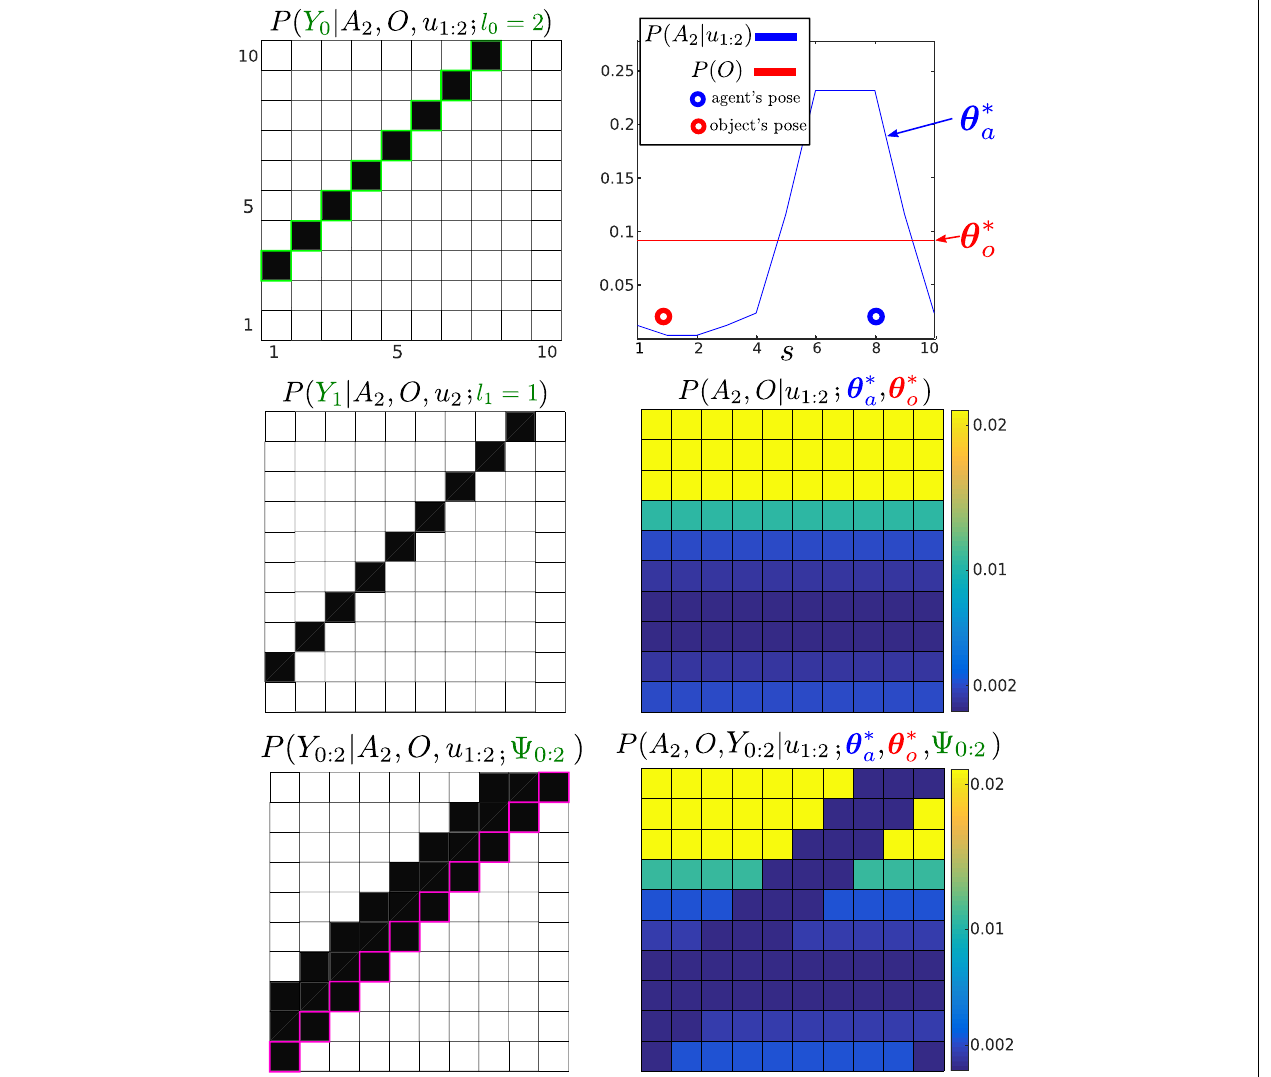
FIGURE 6 | Un-normalized MLMF joint distribution, numerator of equation (12), at time t = 3. Three measurements (all Y = 0) and two actions (both u = 1) have been integrated into the joint distribution, for simplicity we do not consider any motion noise. Left column: the first plot illustrates the likelihood of the first measurement Y 0 . We highlight the contour in light-green to indicate that it was the first applied likelihood function (see the correspondence with Figure 5 ). The first likelihood function has been moved by the 2 actions, the second likelihood function has been moved by one action (the last one, u 2 = 1), and the third likelihood has had no action applied to it yet. The last applied likelihood function is highlighted in pink, and the product of all the likelihoods since t = 0 until t = 3 is depicted at the bottom of the figure, which is P ( Y 0:2 | A 2 , O , u 1:2 ). Right column: the top figure illustrates the original marginal of the object P ( O ; (cid:18) (cid:3) o ) , which remains unchanged, and the agent’s marginal P ( A 2 | u 1:2 ; (cid:18) (cid:3) a ) , which has moved in accordance to the motion-update function. Their product would result in the joint distribution P ( A 2 , O | u 1:2 ; (cid:18) (cid:3) a , (cid:18) (cid:3) o ) illustrated in the middle figure if evaluated at each state ( i , j ). The bottom figure is the result of multiplying P ( A 2 , O | u 1:2 ; (cid:18) (cid:3) a , (cid:18) (cid:3) o ) with P ( Y 0:2 | A 2 , O , u 1:2 ; (cid:9) 0:2 ) giving the filtered joint distribution (equation